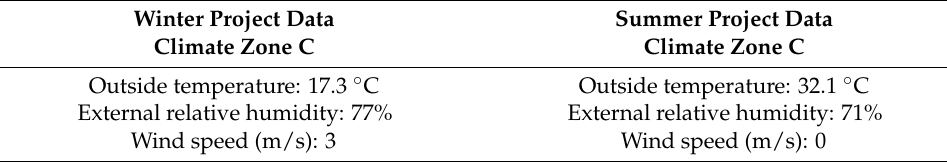
Table 2. The average annual temperature in San Giorgio a